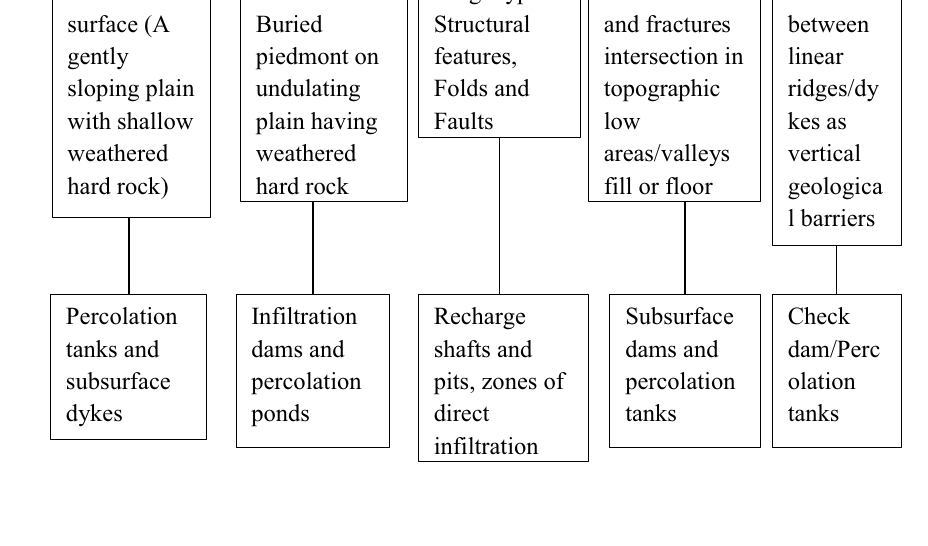
Fig. 17 Decision support model (DSM) based on Slope condi-